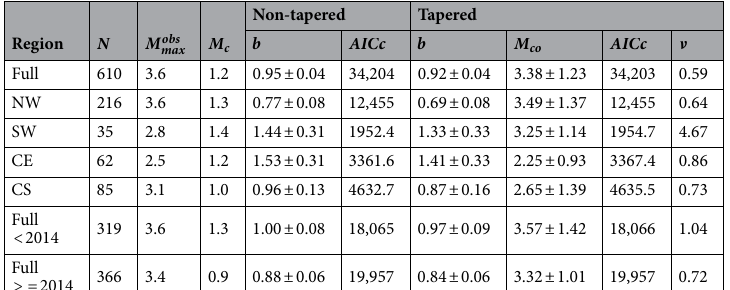
Table 1. Overview of the parameter estimates of the (tapered) earthquake-size distributions and the Akaike Information Criterion corrected for small sample sizes (AICc) test statistics. N indicates the number of events obs with M l ≥ M c , M max is the magnitude of the largest event in the dataset, 1 − σ uncertainty, M co is the estimated corner magnitude with its 1 − σ uncertainty, and ν is the coefficient of variation. Regions (see Fig. 2a): NW northwest, SW southwest; CE central eastern region, CS central southern